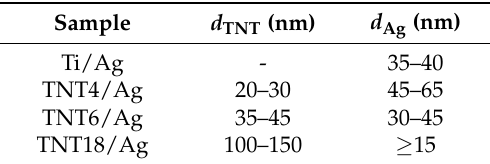
Table 2. Diameters of titania nanotubes and average diameters of silver nanoparticles, which were